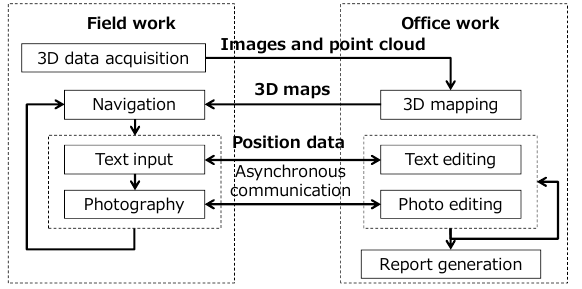
Figure 3. Proposed methodology